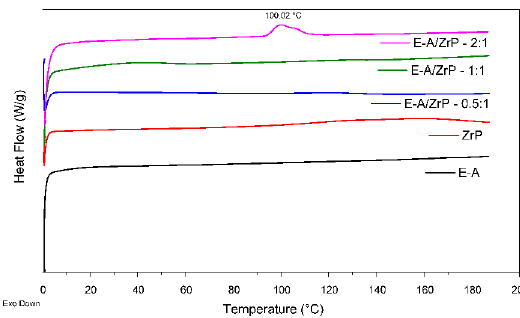
Figure 4. DSC second heating curves of the ZrP and modified zirconium phosphates.